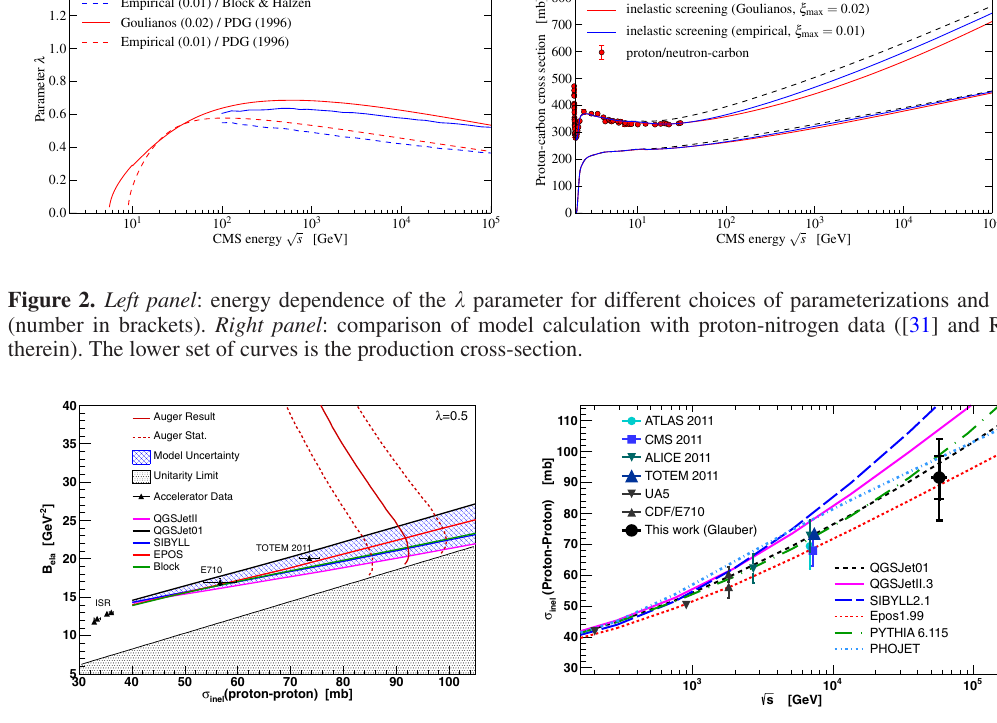
Figure 3. Left panel : correlation of elastic slope parameter, B el , and the inelastic proton-proton cross-section in the Glauber framework. The solid line indicates the parameter combinations yielding the observed proton-air production cross-section, and the dotted lines are the statistical uncertainties. The hatched area corresponds to the predictions by models. Right panel : comparison of derived (cid:2) inel pp to model predictions and accelerator data [28]. Here we also show the cross-sections of two typical high-energy models, PYTHIA6 [29] and PHOJET [30]. The inner error bars are statistical, while the outer include systematic